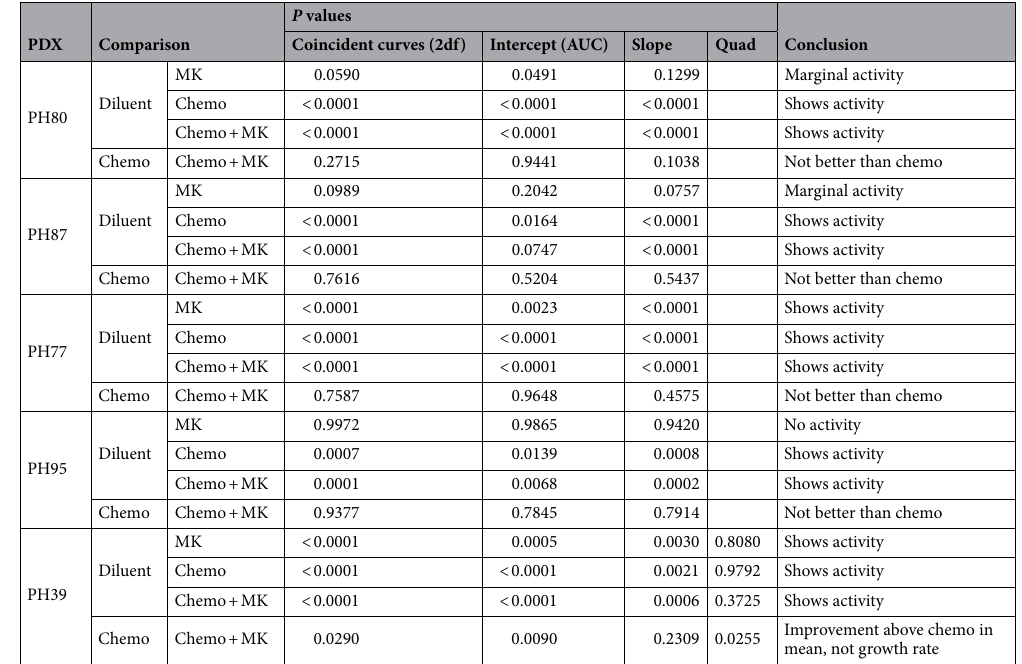
Table 3. Hypothesis testing results using the chosen mean functional form for each PDX model and sp(pow) covariance structure for all PDX models. Comparisons of Chemo versus Chemo + MK assess the primary question of the study, i.e., whether addition of the PARPi MK to chemo improves the performance. Comparisons with diluent assess the secondary question of whether each arm shows activity. The test of coincident curves used 2 degrees of freedom for PH80, PH87, PH77, PH95, and 3 degrees of freedom for PH39. PDX Patient derived xenograft, Sp(pow) Spatial(power), Chemo Chemotherapy, MK MK-4827, PARPi Polymerase inhibitor, AUC Area under the